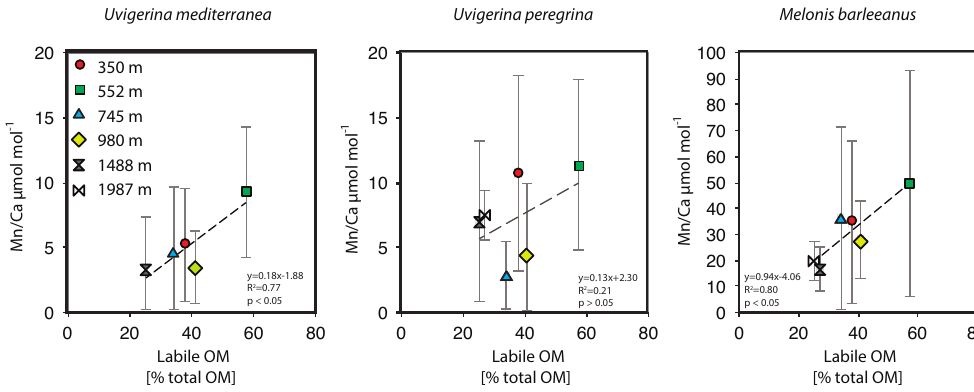
Figure 7. Plots of average Mn / Caµmolmol − 1 versus labile organic matter (% total organic matter).